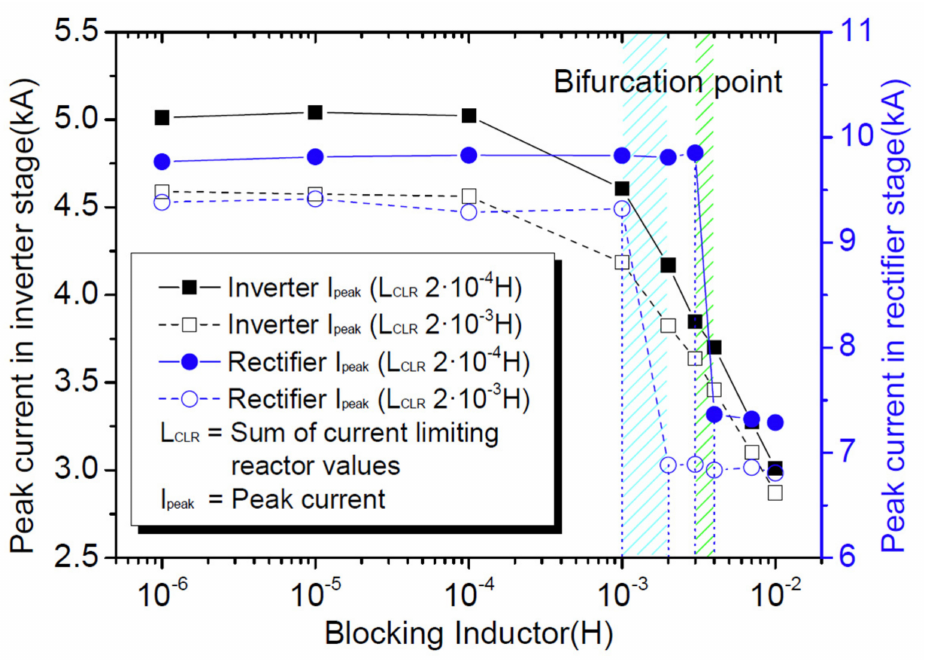
Figure 6. Graph of the peak current in the inverter and rectifier stages depending on the blocking